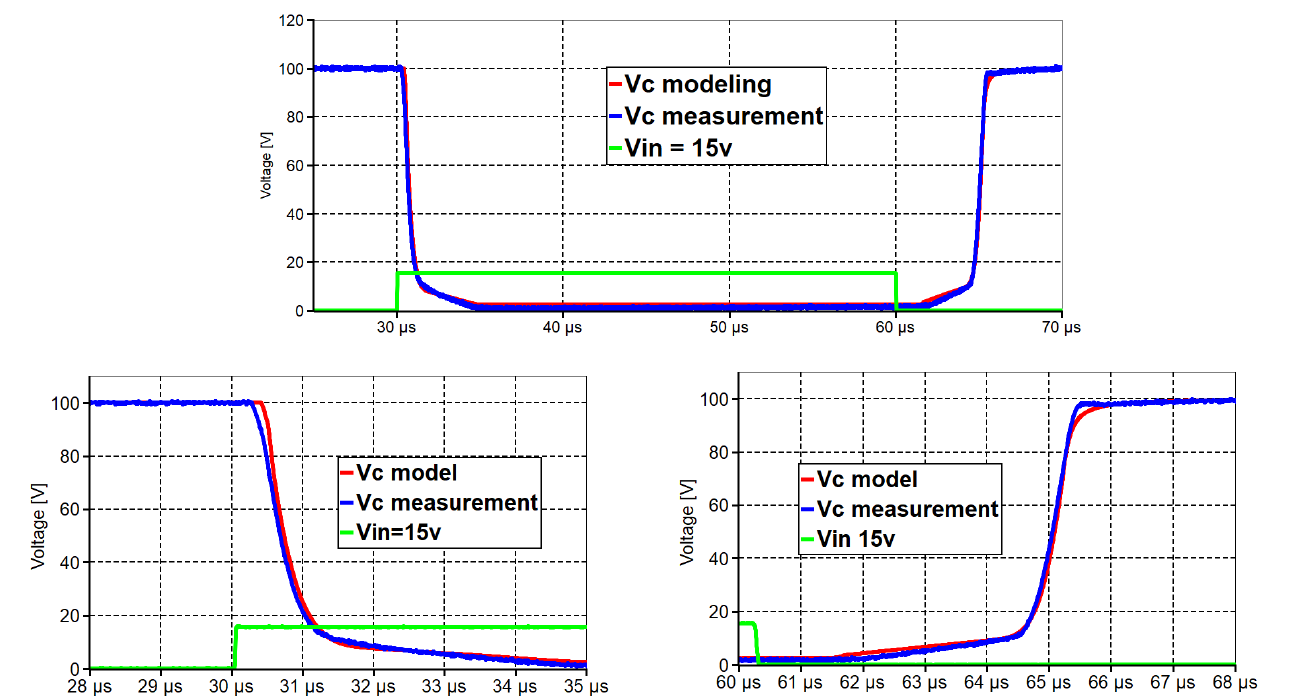
Figure 9. Collector voltage for 15 V input pulse.